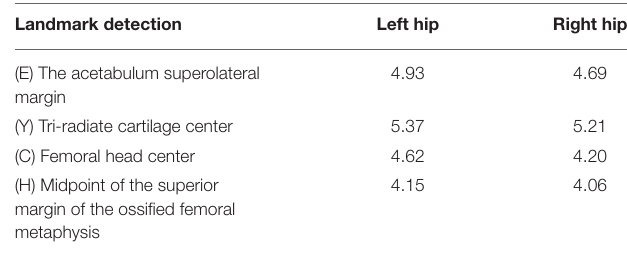
TABLE 1 | Measurement value of landmark detection